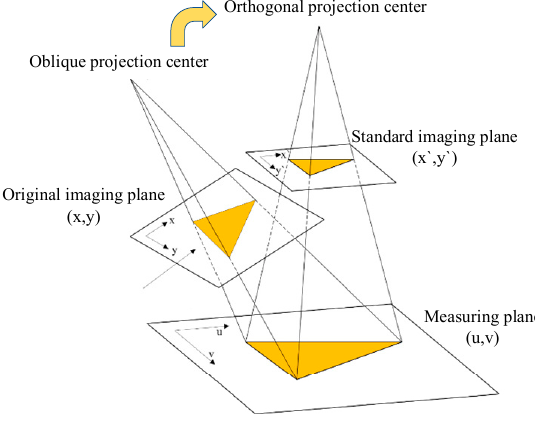
Figure 1. Perspective transformation.